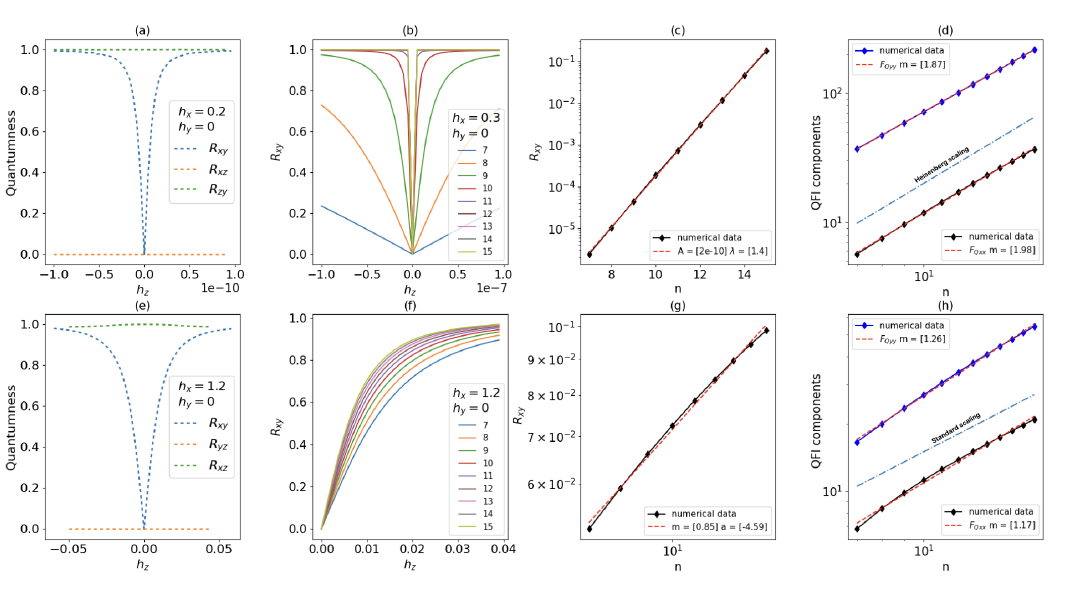
Figure 2: Behaviour of the quantumness and Fisher information in the ordered phase (panels (a-d)) and in the disordered phase (panels (e-h)). In panels (a) and (e) the = 0.2 and h = 1.2, respectively, quantumness is plotted as a function of h for h z x x = 0.3 with n = 11. Panel (b) displays the scaling behaviour of the quantumness for h x as a function of h . Panel (c) plots in a semi-log scale the quantumness as a function z = 0.3 and h ∼ 10 − 10 ): this shows that of n , very close to the first order QPT ( h x z = 0, with a rate which scales exponentially with R decreases abruptly to zero in h x y z n . Analogously, panel (f) displays the dependence of R on h and panel (g) its x y z = 0 and for h = 1.2 (log-log scale): the quantumness dependence on n close to h z x decreases to zero, but in absence of a first order QPT it vanishes with a rate which scales as a power-law in n . In the log-log plots in panel (d) and (h) the scaling behaviour of the components of the QFI is shown with respect to the number of spins = 0.95 both the components are very close to n. In panel (d) it is shown that for h x = 1.2) both the a Heisenberg scaling. Otherwise, in panel (h) in absence of QPT ( h x components are far from a Heisenberg scaling and closer to a normal one. Notice that the fitting parameter m is the slope of the linear fitting, while A and λ are the amplitude and the coefficient of the exponential fitting, respectively. In panel (d) and (h), the blue dashed lines are guides for the eye corresponding to Heisenberg and standard scalings,